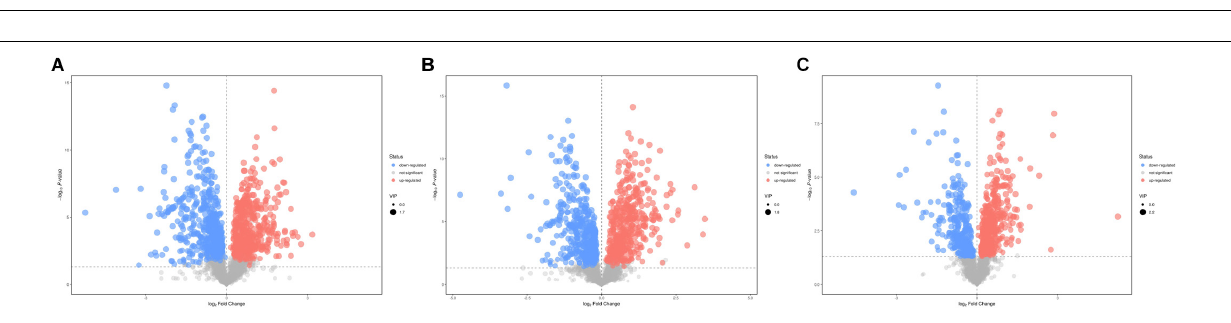
FIGURE 2 | Permutation test of OPLS-DA model showing the stability of the model in ESI+ mode. (A) Permutation test of OPLS-DA model of 4 wpi vs control in ESI+ mode; (B) Permutation test of OPLS-DA model of 8 wpi vs control in ESI+ mode; (C) Permutation test of OPLS-DA model of 8 vs 4 wpi in ESI+ mode. The abscissa indicates the displacement retention of the permutation test, and the ordinate indicates the value of R2Y or Q2. The green dot indicates the R2Y value obtained by the displacement test, the blue square indicates the Q2 value obtained by the permutation test, and the two dotted lines indicate the regression lines of R2Y and Q2, respectively. The point where the displacement retention is 1 is R2Y and Q2 of the original model.